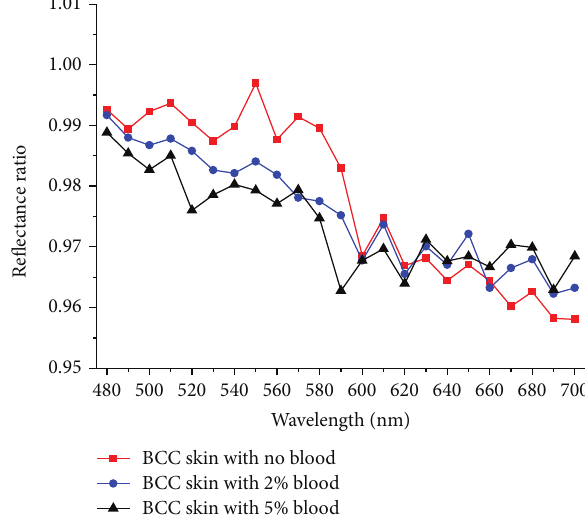
Figure 5: Calculated spectral ratio curves of rebuilt